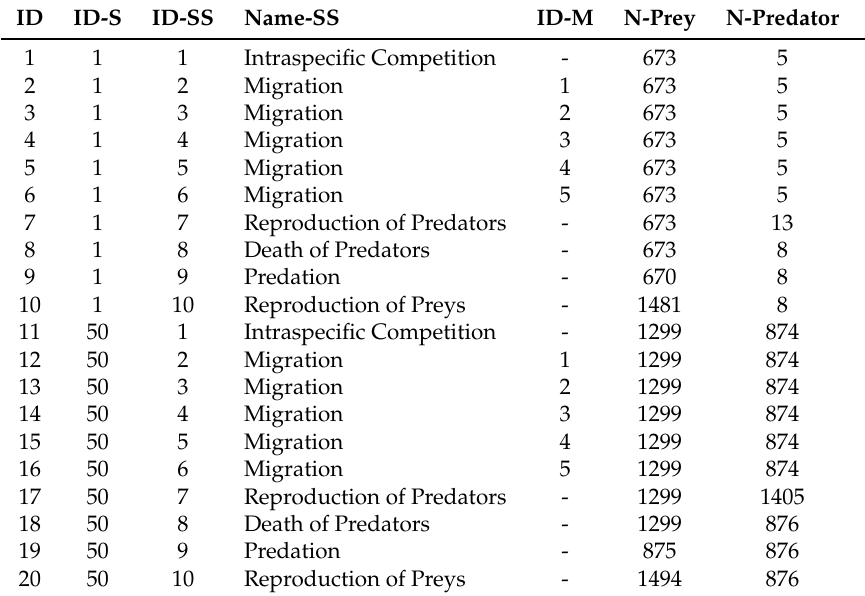
Table 12. Simulation performed using agents—Case D.